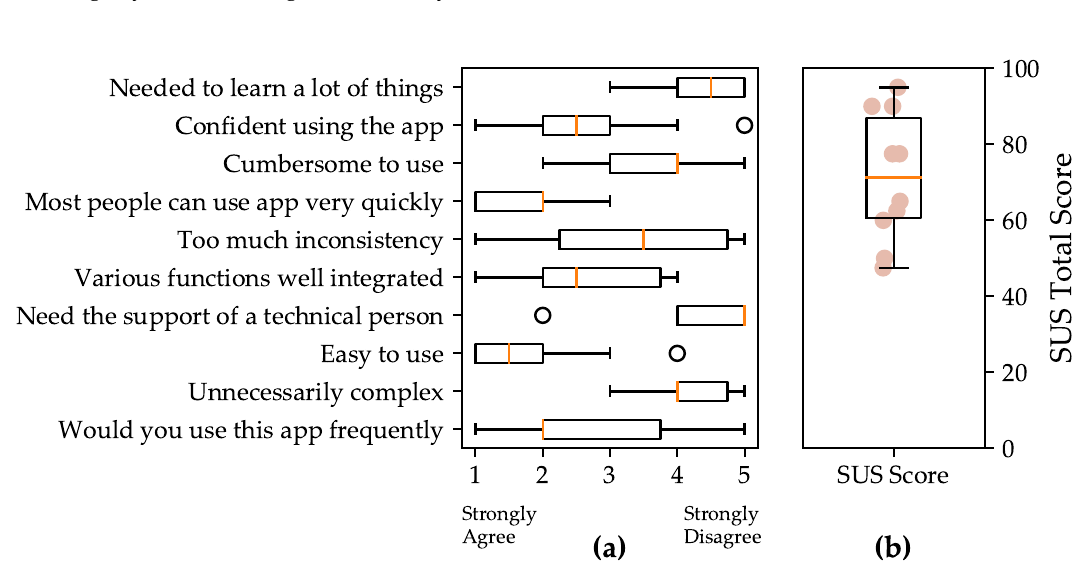
Figure 6. Results of the System Usability Scale: ( a ) the distribution of responses for each question; and ( b ) the distribution of the SUS total